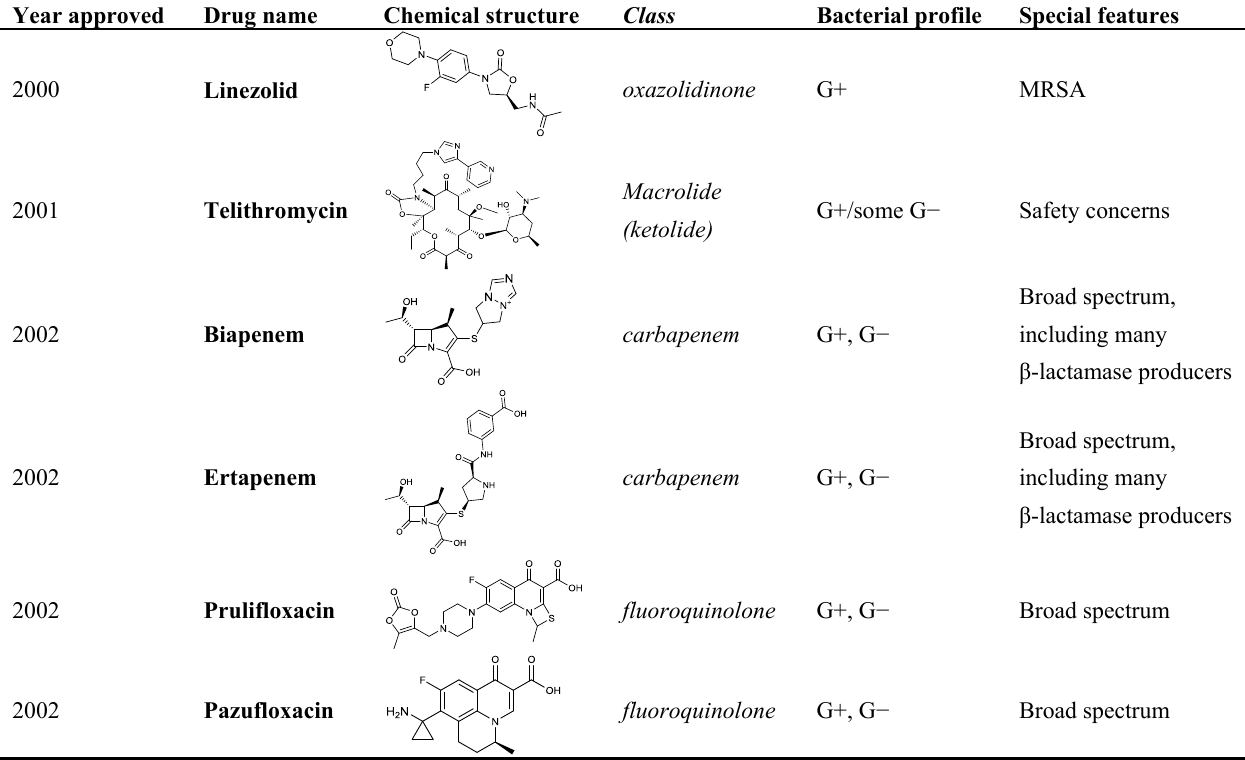
Table 1. Antibiotics approved since